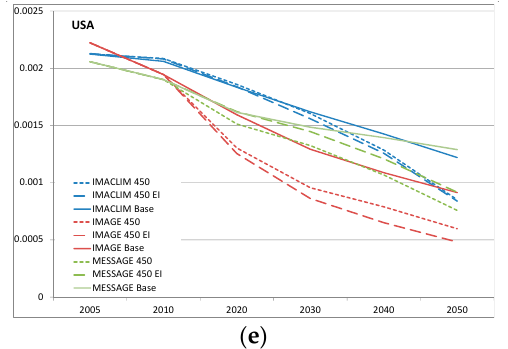
Figure B5. Inter-model comparison of the change in energy intensity in the transport sector in ( a ) World (Annual rate of energy intensity improvement: 2005–2010 = 2%, 2010–2050 = 1% to 3%); ( b ) China (Annual rate of energy intensity improvement: 2005–2010 = 1%, 2010–2050 = − 1%–4%); ( c ) The EU (Annual rate of energy intensity improvement: 2005–2010 = 1%, 2010–2050 = − 2%–4%); ( d )